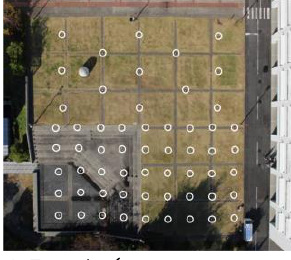
Figure 1. Test site ( white circles signify check